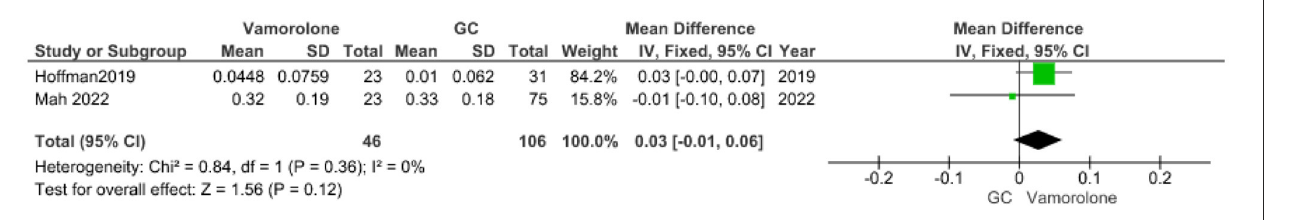
FIGURE7 TTCLIMB outcome vamorolone vs. glucocorticoids.